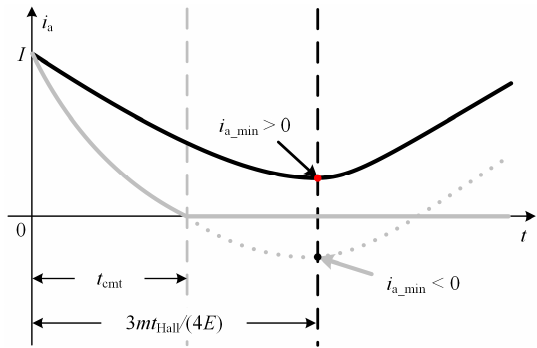
ff ect of back-EMF variation on the outgoing phase Figure 5. The effect of back-EMF variation on the outgoing phase current. Figure 5. The e